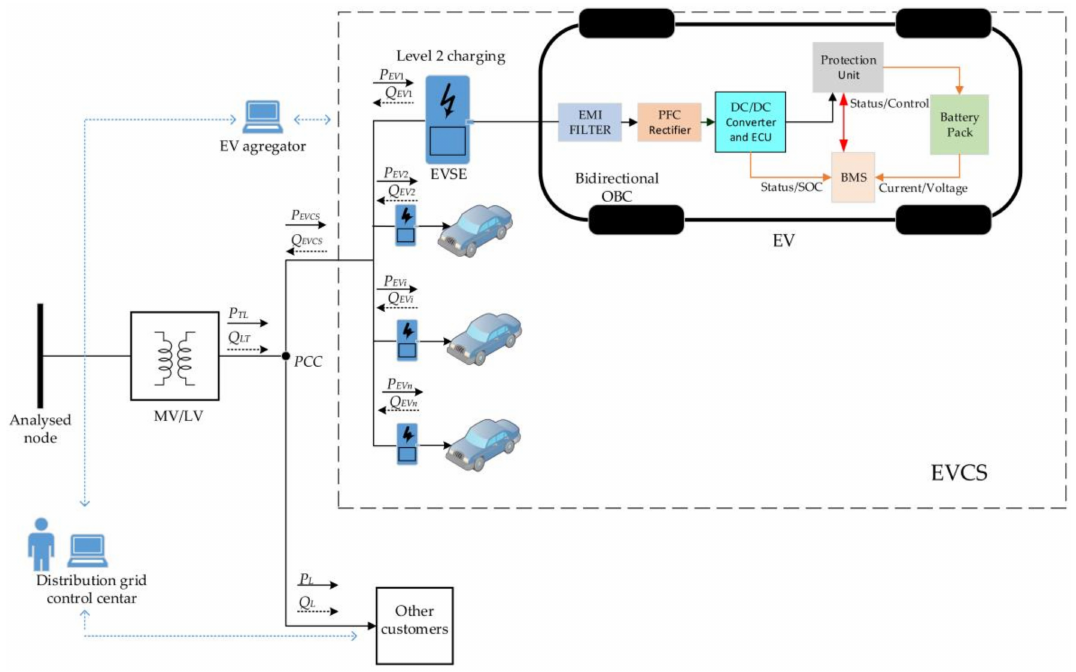
Figure 3. Proposed reactive power support diagram using OBC from